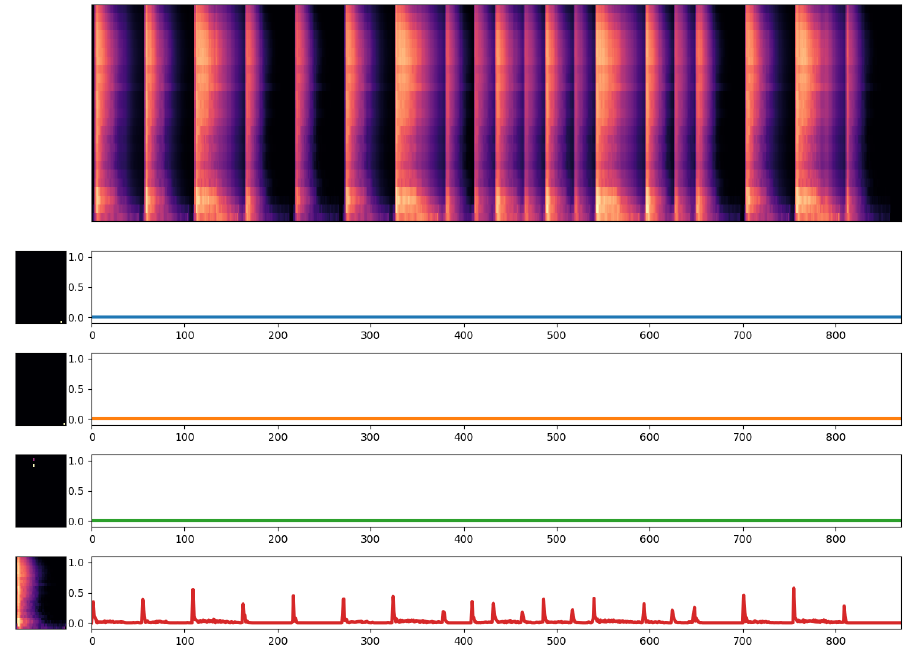
Figure 5. Decomposition of a drum loop using sparse NMFD, λ = 1.0. The decomposition fails because the sparsity constraint is too strong, so that only one component remains